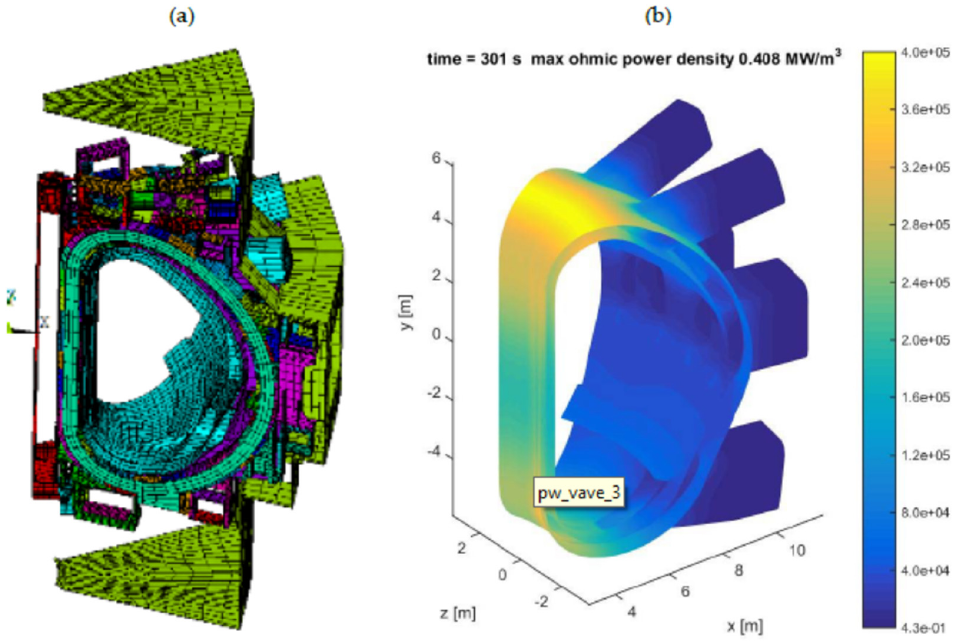
Figure 5. Case study 2: ( a ) a 40° sector of ITER magnet system; ( b ) distribution of ohmic power density at a given time instant during the considered transient event.